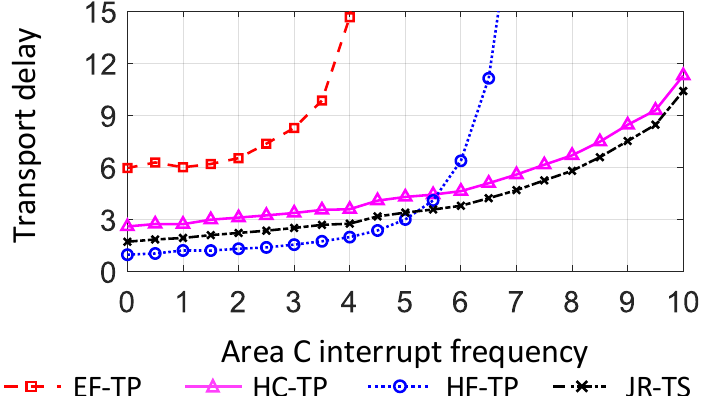
Figure 14. Transport performance in heterogeneous IoV test environment.